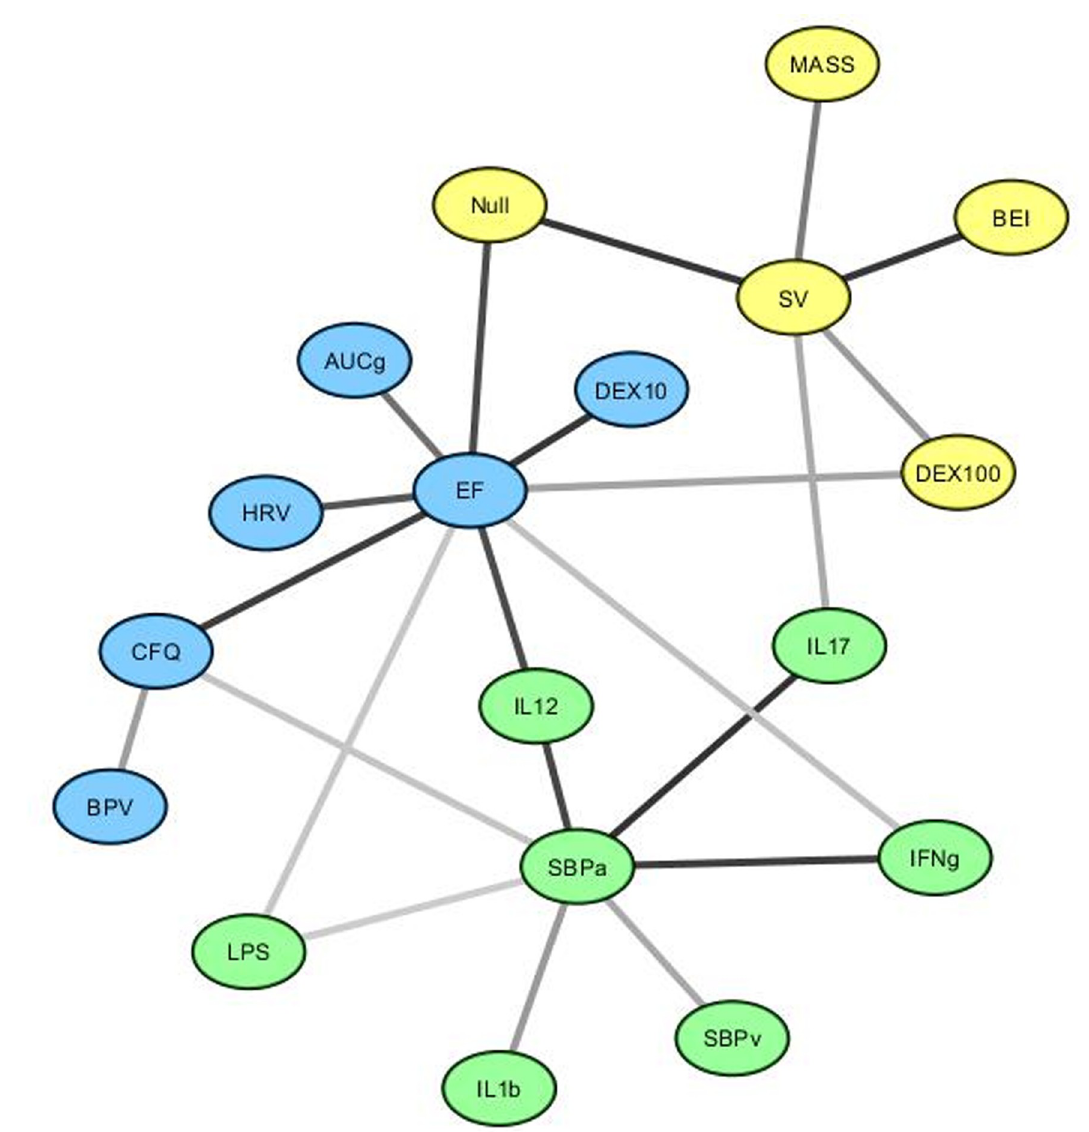
Fig 3. Interactions between the ANS, immune system and HPA axis in CFS. Edge shade is related to MI between nodes. Darker edges indicate a stronger link. Abbreviations: AUCg- Area under the curve with respect to ground, BEI- Baroreflex effectiveness index, BPV- Blood pressure variability, CFQ- Total Cognitive Failures Questionnaire score, DEX10- in vitro glucocorticoid receptor response to 10% dexamethasone solution, DEX100- in vitro glucocorticoid receptor response to 100% dexamethasone solution, EF- Ejection fraction, HRV- Heart rate variability, LPS- in vitro glucocorticoid receptor response to lipopolysaccharide, MASS- End diastolic wall mass, Null, in vitro glucocorticoid receptor response without stimulation, SBPa- Mean systolic blood pressure during active stand, SV- Stroke